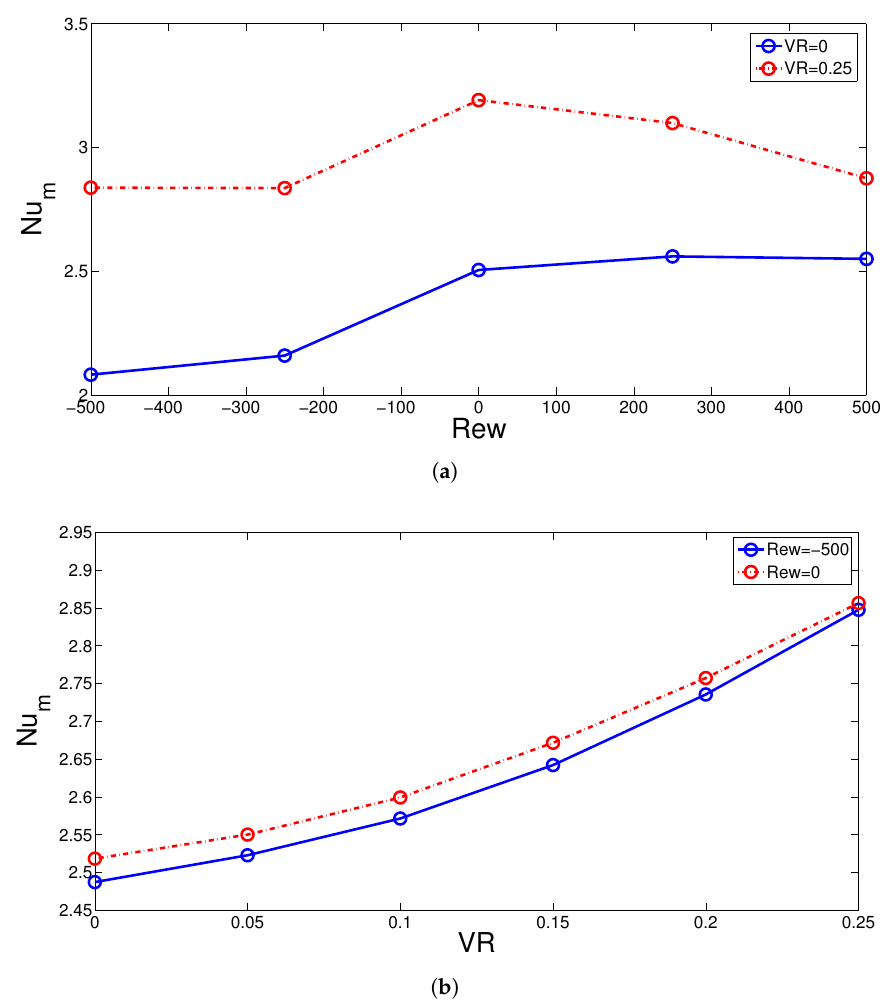
Figure 7. Average Nu versus Rew ( a ) and versus VR ( b ) (Ha = 5, Mx = − 1). The impacts of MGF strength on streamline variations are shown in Figure 8a–h considering both rotating and non-rotating CC cases. When CCs are not rotating (Rew = 0) at Ha = 0, large vortices near the bottom wall (left part), near the right CC on the top wall and near the inlet are established. When MGF strength is increased to Ha = 5, the top and bottom wall vortices are significantly suppressed while at the highest MGF strength (Ha = 20), and most have disappeared. Similar observations can be made with higher